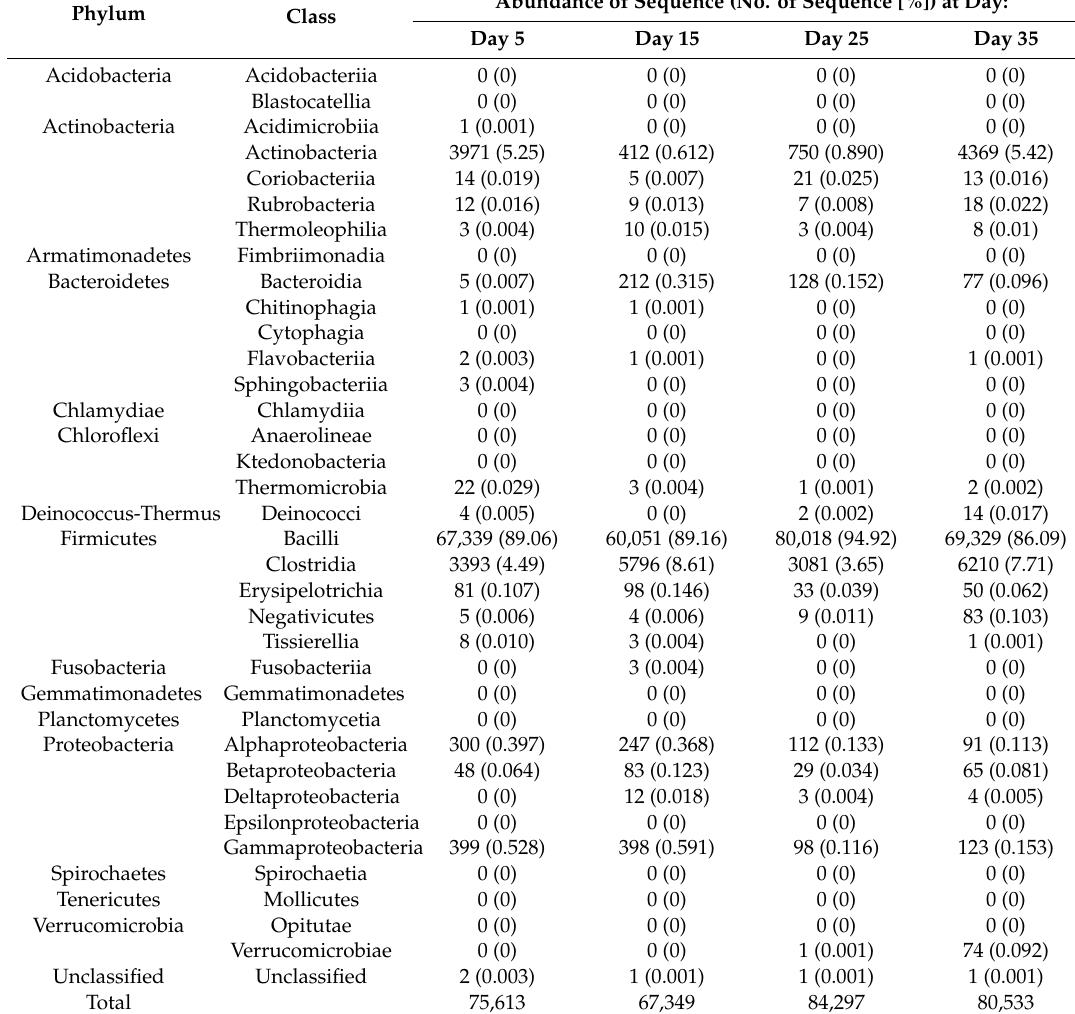
Table 8. Abundance of bacterial 16S rDNA sequences ( n = 307,792) isolated from the jejunum microbiota of Omani